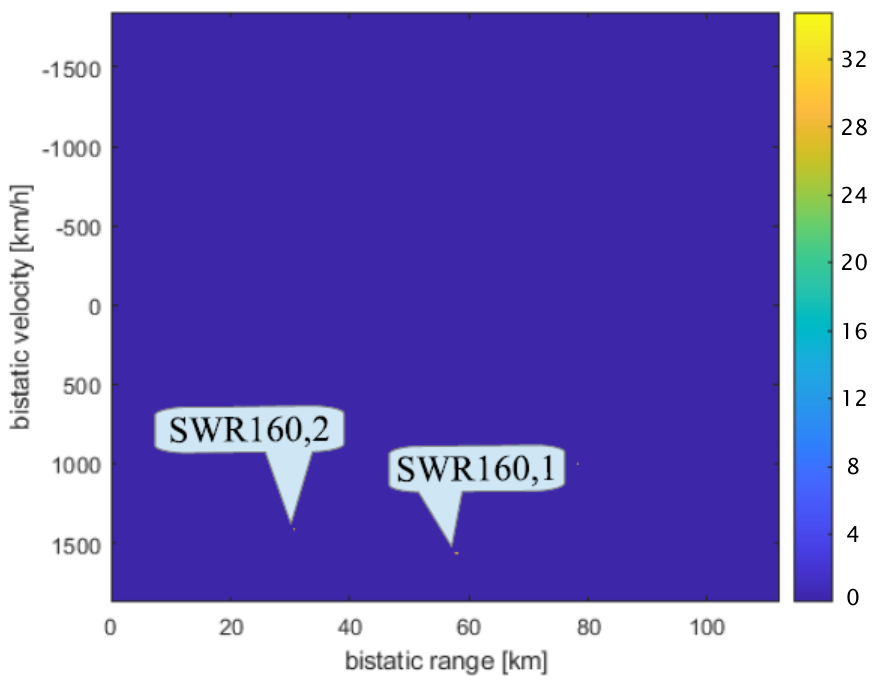
Figure 20. Cross-ambiguity function for the surveillance signal acquired by one